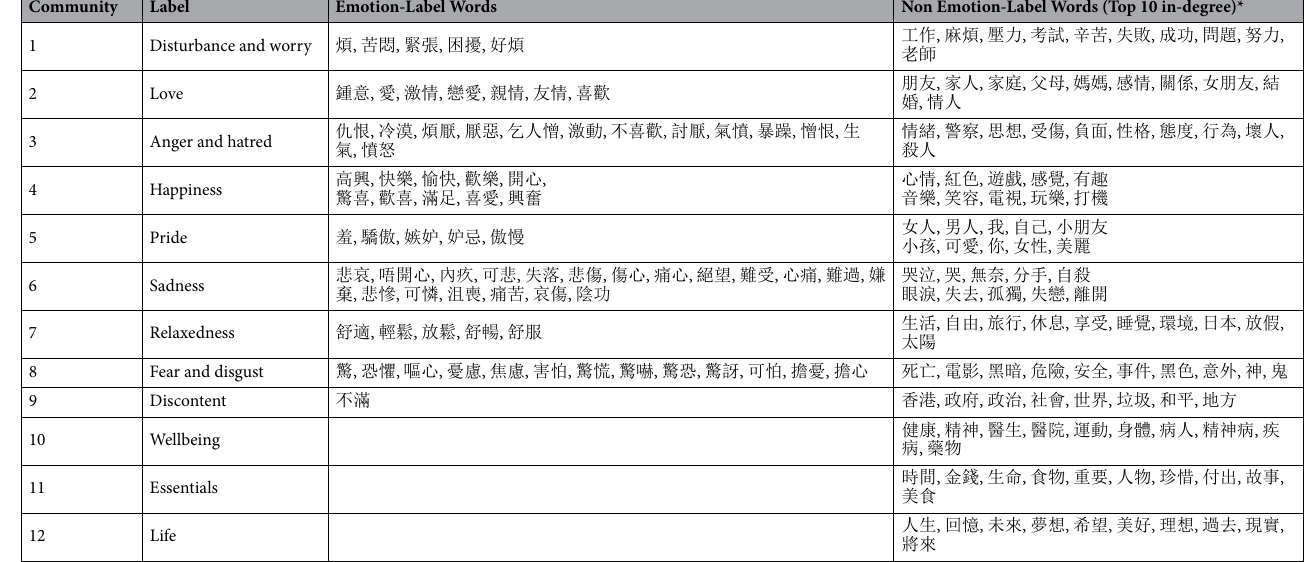
linkage between emotion labels and relevant conceptual knowledge could be evolutionarily rooted (e.g., fear and darkness) or recently formed (e.g., discontent and policies). We also identified three communities without emotion labels. These communities may represent emotion-laden words that are closely connected to emotion labels. Finally, we examined the microscopic properties of certain emotion labels. The results revealed that the abilities of emotion graphs with concepts can differentiate emotion labels with similar meanings, such as nodes connected to synonyms of surprise ( 驚喜 ging1hei2, 驚訝 ging1ngaa6) were different from each other. Languages that dominate western cultures (e.g., English) are mostly spoken in low-context cultures, while the languages that dominate eastern cultures (e.g., Mandarin, Cantonese) are generally used in high-context cultures. Words in Western cultures generally have universal meanings and people pay less attention to the communication context 45 . People with Eastern cultural backgrounds are more likely to communicate beyond words and use the same word differently in specific contexts 45 . In hierarchical clustering, the contextual profiles related to each emotion category are missing. For example, words from the same emotion types were assigned to different clusters, such as 煩厭 ( boredom , faan4jim3) in cluster B, while 厭惡 ( disgusted , jim3wu3), 討厭 ( dislike , tou2 jim3) in cluster C. Besides, words with the same English translation were identified in different clusters. This partial semantic equivalence between English and Cantonese was demonstrated specifically for surprise ( 驚喜 ging1hei2, 驚訝 ging1ngaa6). The fuzziness in the boundaries of emotion clusters in hierarchical clustering analysis may be due to the communication custom in Chinese. For the same emotion cue words, the responders may conceptualize them in a specific context that varies among people. If emotions were categorized in terms of affective features, we only identified two superordinate clusters covering a general positive–negative dimension. In the setting of our study, hierarchical clustering could not offer a precise clustering of emotion labels. This may be due to the unique characteristics of Chinese emotion-label words. However, further analysis in English using the same settings is needed to confirm these findings. Comparing clustering using ratings, an emotion graph can better differentiate emotions into relevant prototypical ones. Altogether, more work in which clustering solutions across languages are compared is needed to corroborate these claims. At a macroscopic level, the G emotion has a small-world structure which was characterized by short averaged shortest path-lengths and a significant degree of clustering (Table S4 in supplementary material). Along with previous reports, G emotion , as a mental graph, its hubs expressed psychological importance 15 . Some associations between emotions and non-emotion words are “inherited” while some of the others are linked recently. For example, 黑暗 ( darkness ) and 黑色 ( black ) were grouped with 驚 (fear). This is consistent with previous research that proposed fear is an inherent default response to the unknown and the fear response is disinhibited under uncertainties (e.g., dark environment) 46,47 . Besides, the association may reflect evolutionary importance for survival 48 . For example, 黑暗 ( darkness ) and 黑色 ( black ) indicate potential threats and dangers, and this aligns with previous research on the association between fear and the color black 49 . The conceptual knowledge of fear linking to threatening instances may have a long history tracing back to our ancestors. Recent instances could generate a strong linkage to a specific emotion, which forms the generated associations. For example, since 2014, Hong Kong has been going through a series of events causing social unrest. We found that the emotion-label word 不滿 ( discontent ) was grouped with cues including government, society, and politics. Excessive violent acts by the police during social unrest may lead to an association between 警察 (police) and emotion labels in